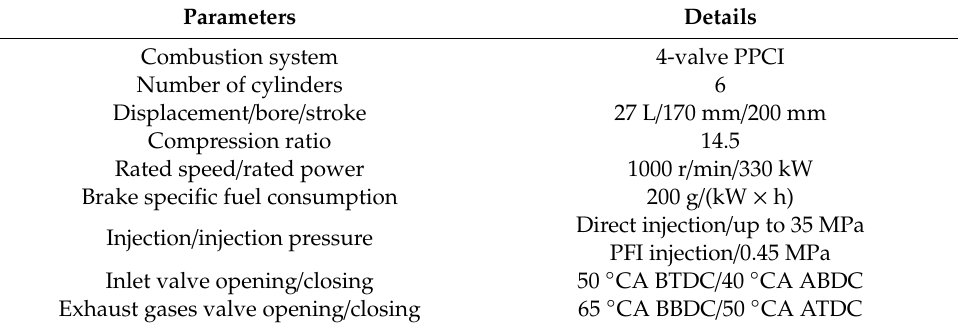
Figure 1. Schematic of the experimental setup. Table 1. Specifications of the engine.